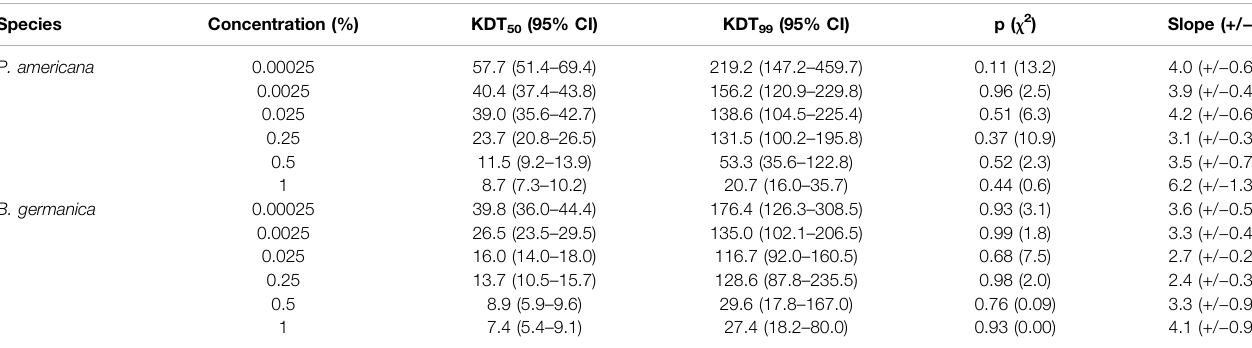
TABLE 1 | Deltamethrin exposure knock-down values for P. americana and B. germanica . Species Concentration